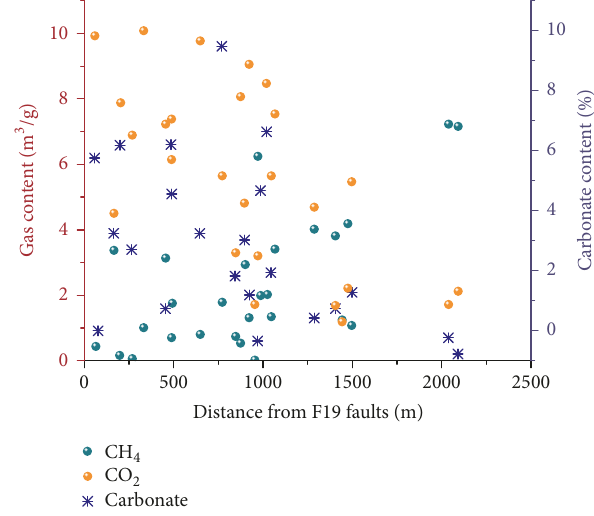
Figure 4: Changes of CO 2 and carbonate distributions as the distance from F19